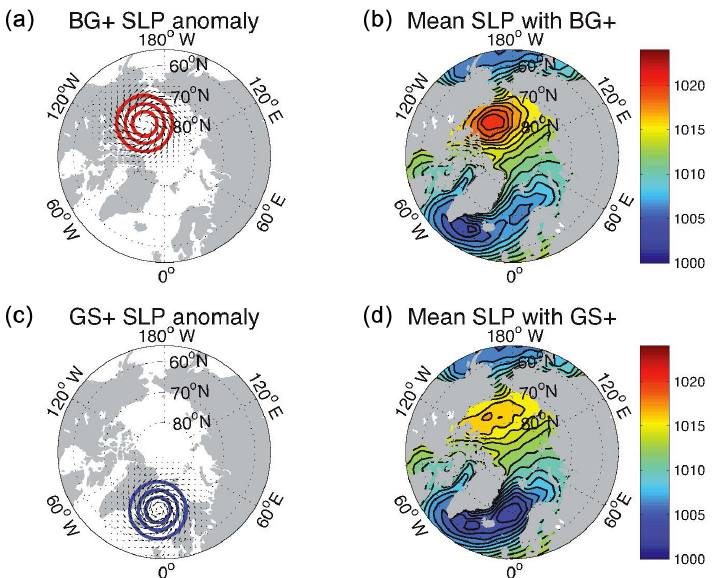
Figure 5. (a) Idealized sea-level pressure anomaly of 4hPa and associated winds constructed for the Beaufort Gyre (BG). Note that the BG ( + ) corresponds to anomalously high pressure. (b) BG ( + ) SLP anomaly added to the NCEP 1981–2010 SLP climatology. (c) Ideal- ized sea-level pressure anomaly of 4hPa and associated winds constructed for the Greenland Sea (GS). Note the GS ( + ) corresponds to anomalously low pressure over the GS. (d) GS SLP anomaly added to the 1981–2010 SLP climatology. The contour interval in (a) – (d) is